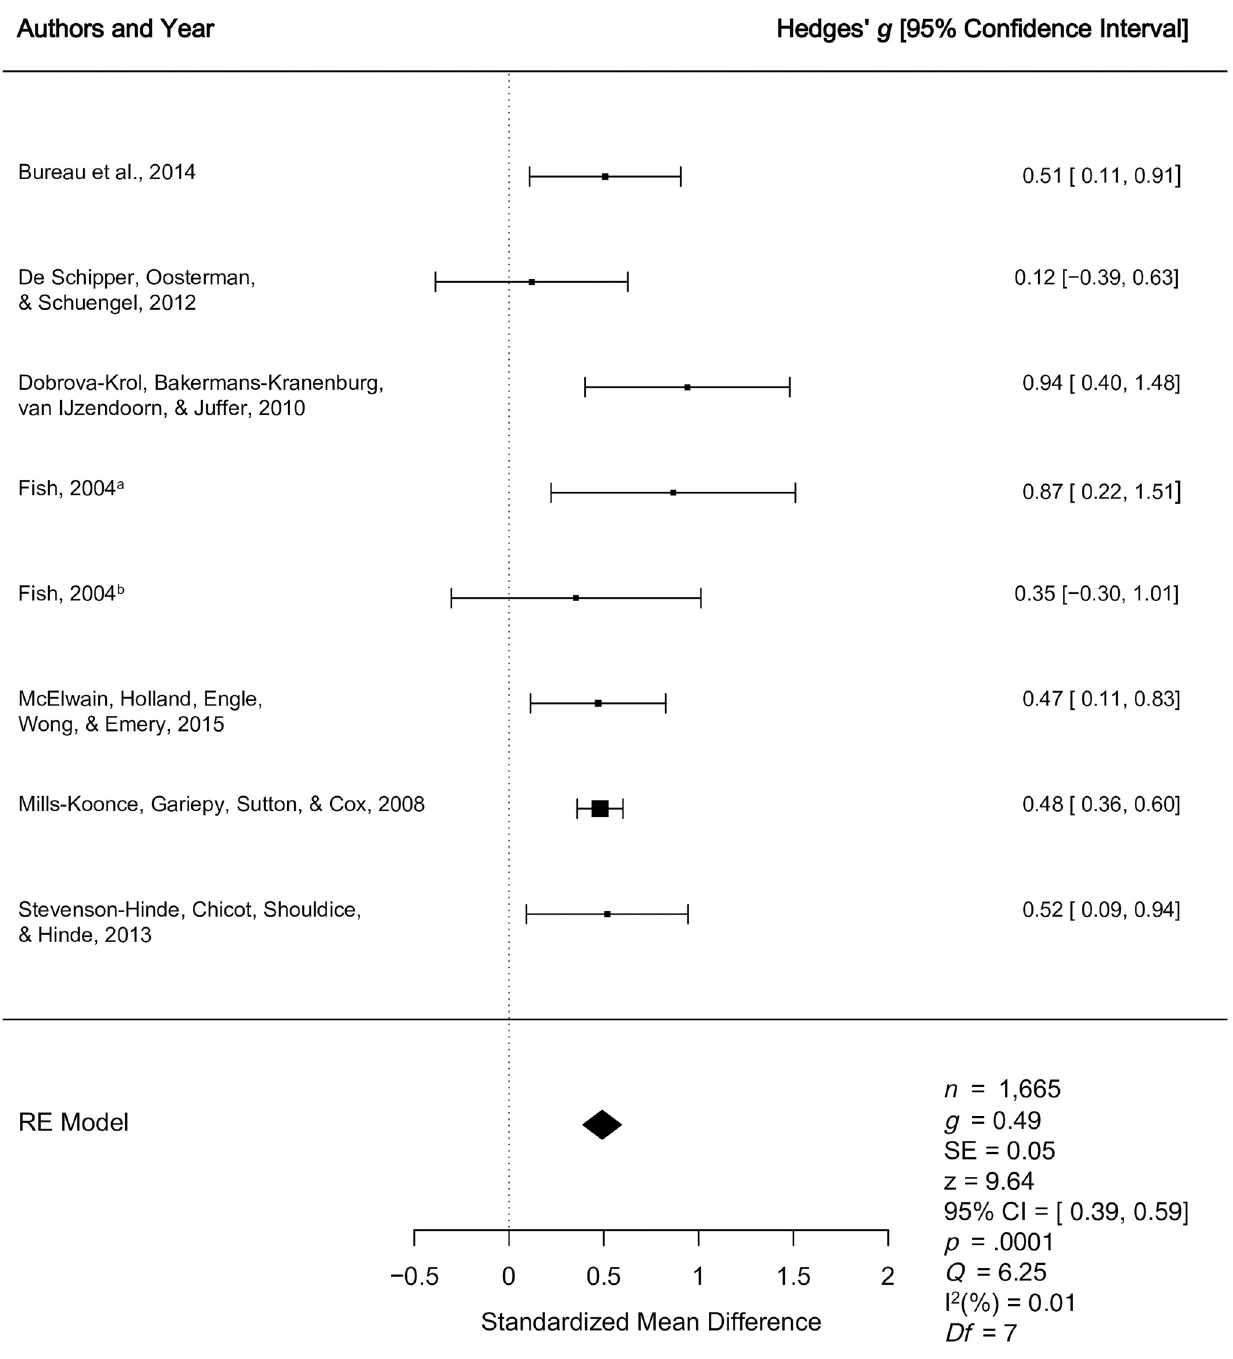
Fig 9. Forest plot for the concurrent relationship between multidimensional caregiver sensitivity and secure versus insecure preschool attachment. RE = Random Effects Model; g = Hedges’ g; Q = Cochran’s heterogeneity statistic; Q; I 2 = percentage of variability across studies that is due to between- study